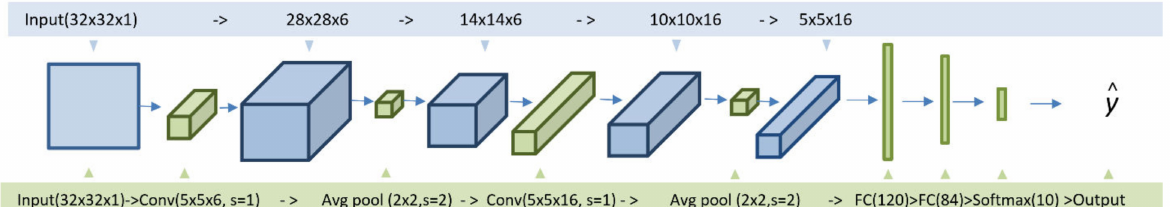
Figure 8. LeNet network architecture. Source: generated by the